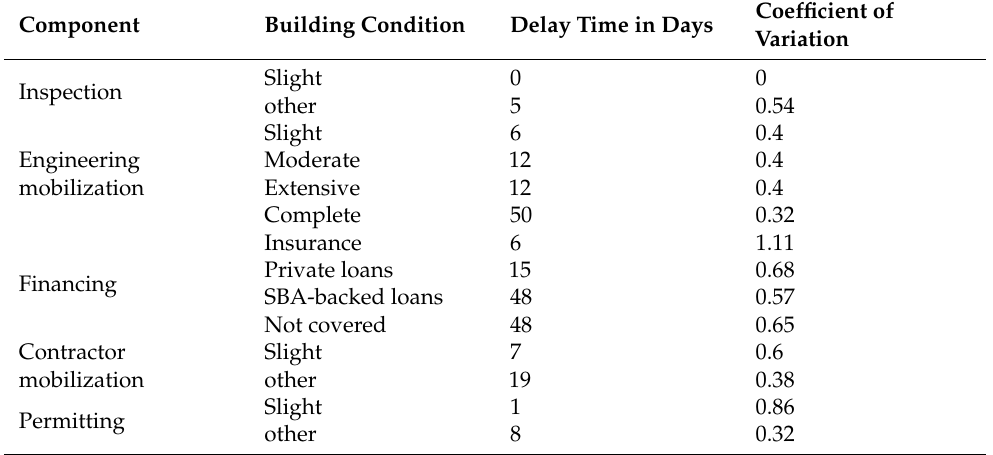
Table A6. Delay time